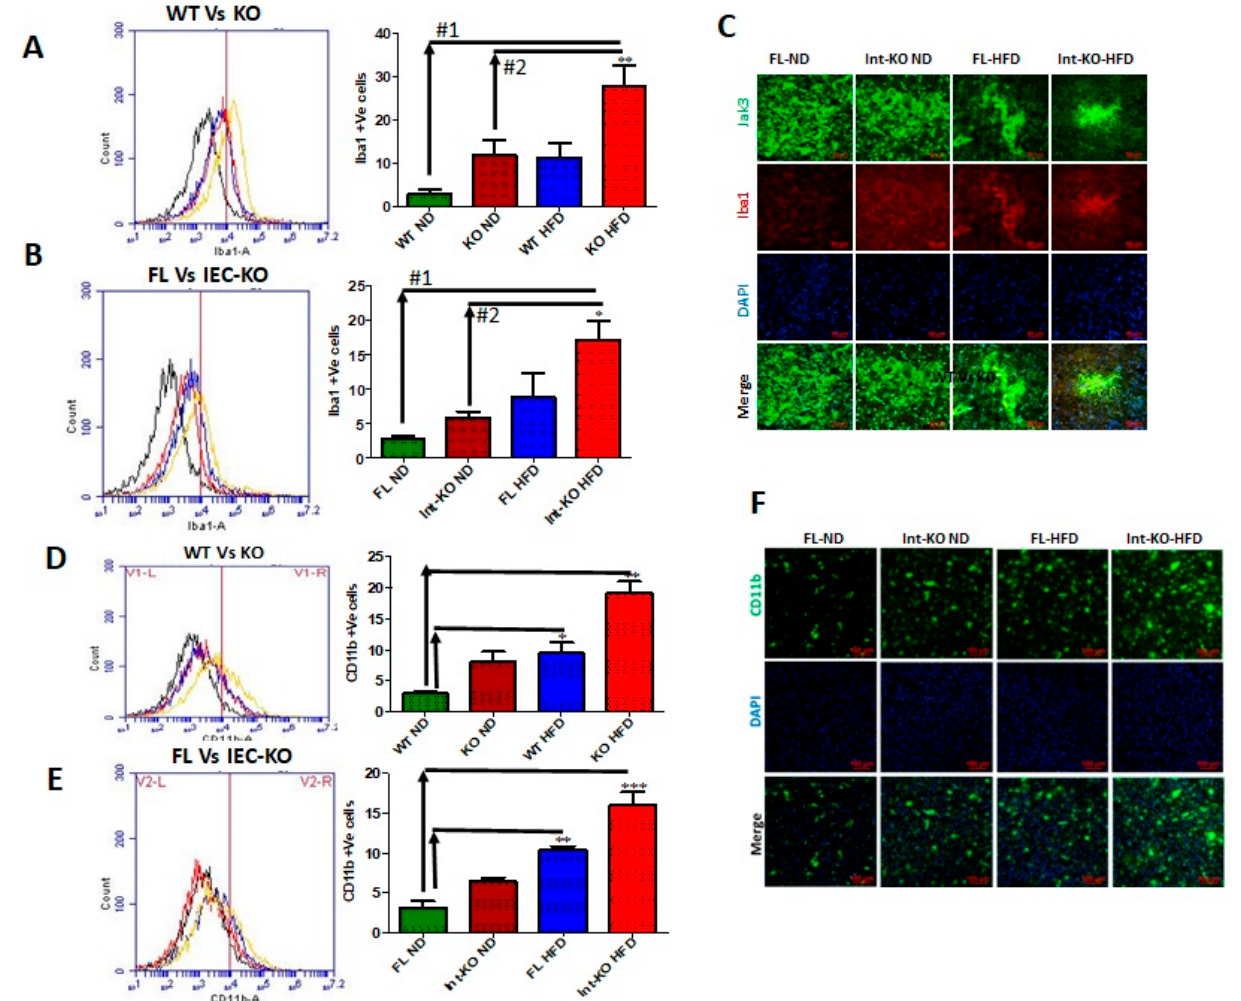
Figure 5. Intestinal deficiency of Jak3 leads to increased microglial activation in the brain during HFD-induced obesity. The impact of global ( A , D ) and intestinal epithelial tissue-specific ( B , E ) deficiencies of Jak3 on brain expression of microglial marker TREM-2 was determined in ND- and HFD-fed mouse brain. Representative flow cytometric histogram graphs of individual mouse brain cells showing the microglial levels of expression of Iba1 in the four indicated groups of global deficiency or IEC deficiency, respectively ( n = 5/group), are shown in the left panel, and the corresponding histogram bar graphs indicating mean ± SD values in the right panel are shown for the comparative average cell counts for the indicated groups of mice. *, **, *** Indicate statistically significant difference from the corresponding controls (( A ): KO-HFD#1 p = 0.05, KO-HFD#2 p = 0.03; ( B ): IEC-KO-HFD#1 p = 0.05, IEC-KO-HFD#2 p = 0.04; ( D ): WT-HFD p = 0.05, KO-HFD p = 0.03; ( E ): FL-HFD p = 0.07, IEC-KO-HFD p = 0.04). ( C ) Brain tissue sections from flox-Jak3-control littermate and IEC-Jak3-KO mice fed with either ND or HFD were immunostained using microglial marker Iba1 primary antibodies followed by Cy3 secondary antibodies, and mounting media containing PI were used to visualize the nucleus. Representative images ( n = 10) are shown. ( E ) Brain tissue sections from flox-Jak3-control littermate and IEC-Jak3-KO mice fed with either ND or HFD were immunostained using microglial activation marker CD11b primary antibodies followed by FITC secondary antibodies, and mounting media containing PI were used to visualize the nucleus. ( F ) Similar experiments were performed as in “C” except the brain tissue sections were immunostained using microglial activation marker CD11b primary antibodies followed by FITC-conjugated secondary antibodies. (C&F) Representative images ( n = 10) are